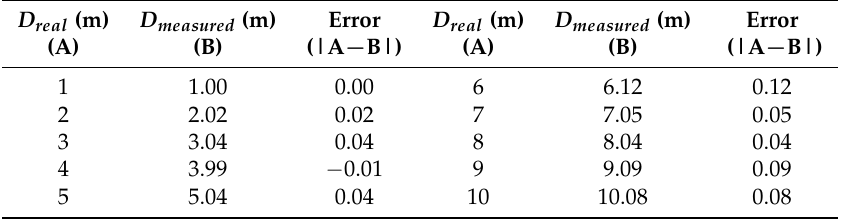
Table 2. Measured distance from smartphone to marker using milliradian